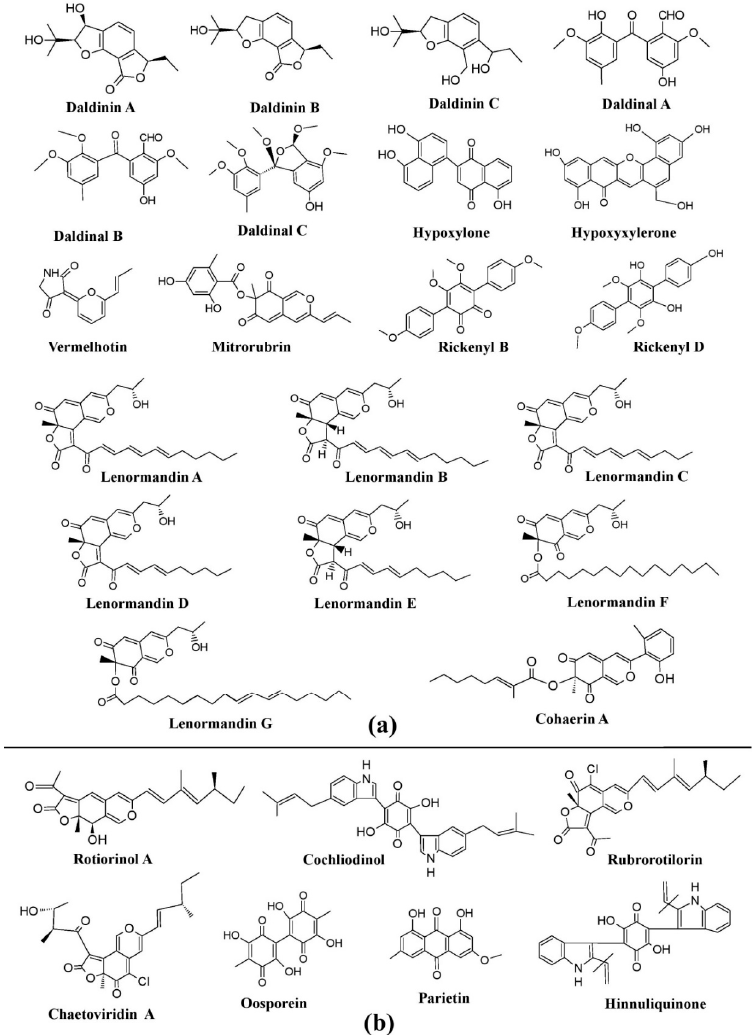
Figure 8. Pigments from the fungi of Xylariaceae and Chaetomiaceae families. ( a ) Pigments from members of the Xylariaceae family (species of Daldinia , Hypoxylon , and Jackrogersella ), re-drawn from [25]. ( b ) Pigments from members of the Chaetomiaceae family (species of Chaetomium and Achaetomium ) and Hypoxylaceae, re-drawn from [25,84].